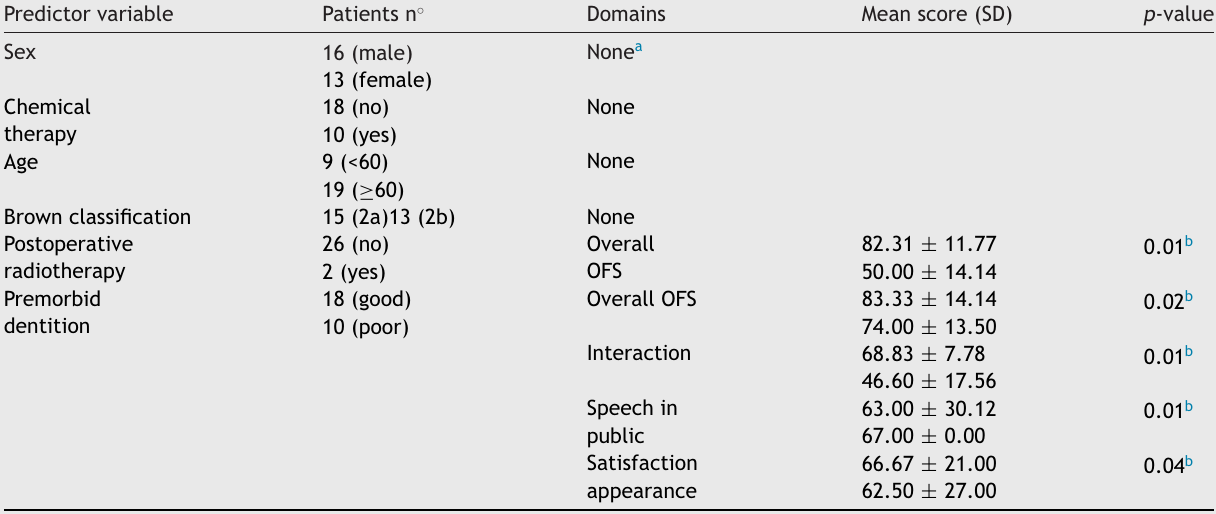
Impact of treatment and demographic variables on selected individuals.